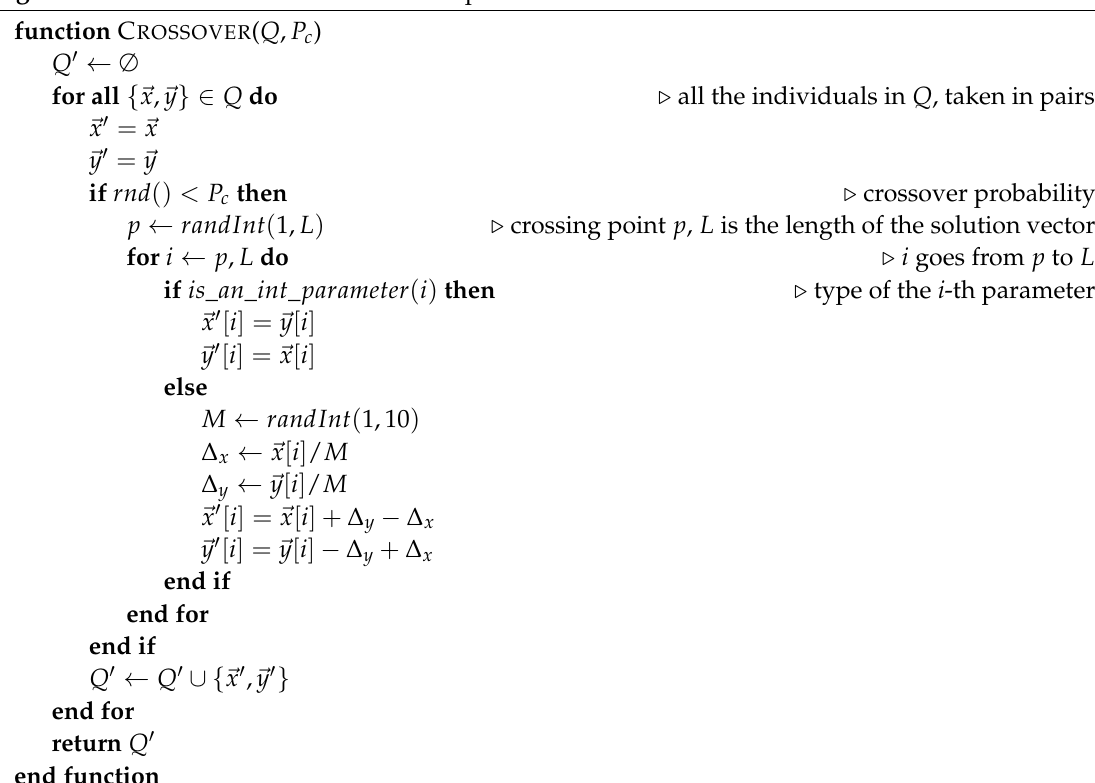
Algorithm 3 Pseudocode of the crossover operator. function C ROSSOVER ( Q , P c